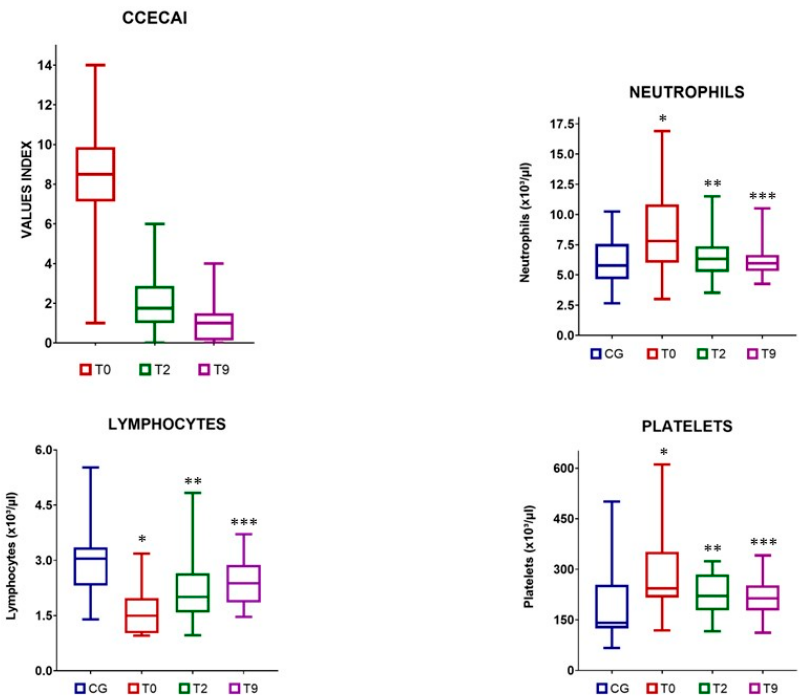
Figure 1. Canine Chronic Enteropathy Clinical Activity Index (CCECAI), neutrophil, lymphocyte, and platelet values in the control group (CG) and in dogs with chronic inflammatory enteropathy (CIE) treated with stem cells at different time points: before administration (T0), at 2 months (T2), and at 9 (T9) months after therapy. Neutrophils: * p = 0.03; effect size (95% CI): 0.78 (0.08; 1.45); ** p = 0.644; effect size (95% CI): − 0.04 ( − 0.70; 0.61); *** p = 0.962; effect size (95% CI): − 0.19 ( − 0.84; 0.47). Lymphocytes: * p < 0.0001; effect size (95% CI): − 1.62 ( − 2.34; − 0.83); ** p = 0.02; effect size (95% CI): − 0.78 ( − 1.44; − 0.08); *** p = 0.05; effect size (95% CI): − 0.71 ( − 1.37; − 0.02). Platelets: * p = 0.01; effect size (95% CI): 0.77 (0.07; 1.44); ** p = 0.063; effect size (95% CI): 0.36 ( − 0.31; 1.01); *** p = 0.171;